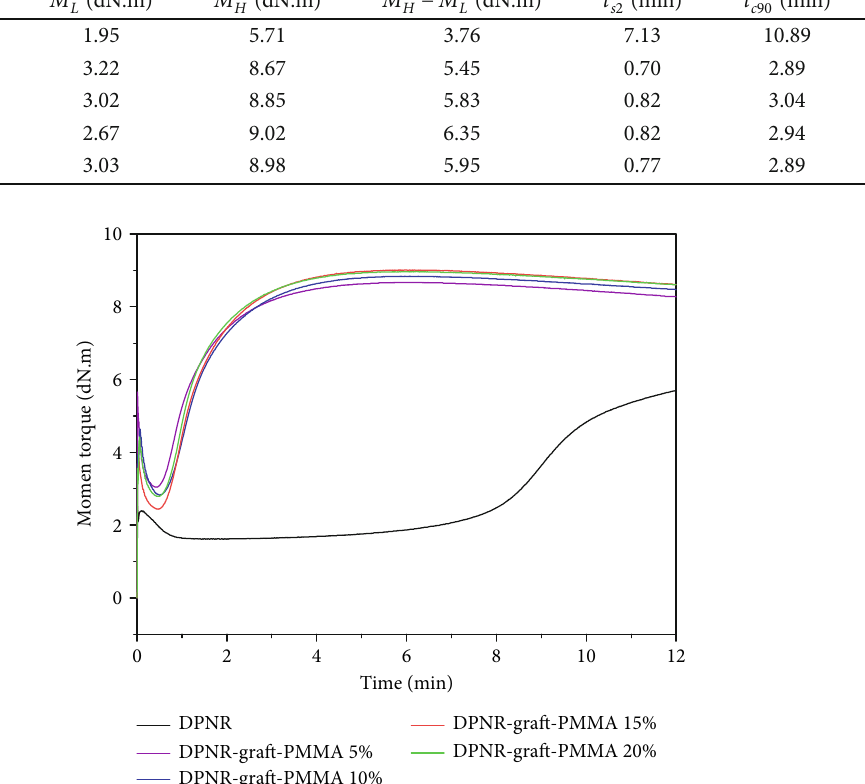
Table 3: The cure characteristics for DPNR and DPNR-graft-PMMA samples. Samples